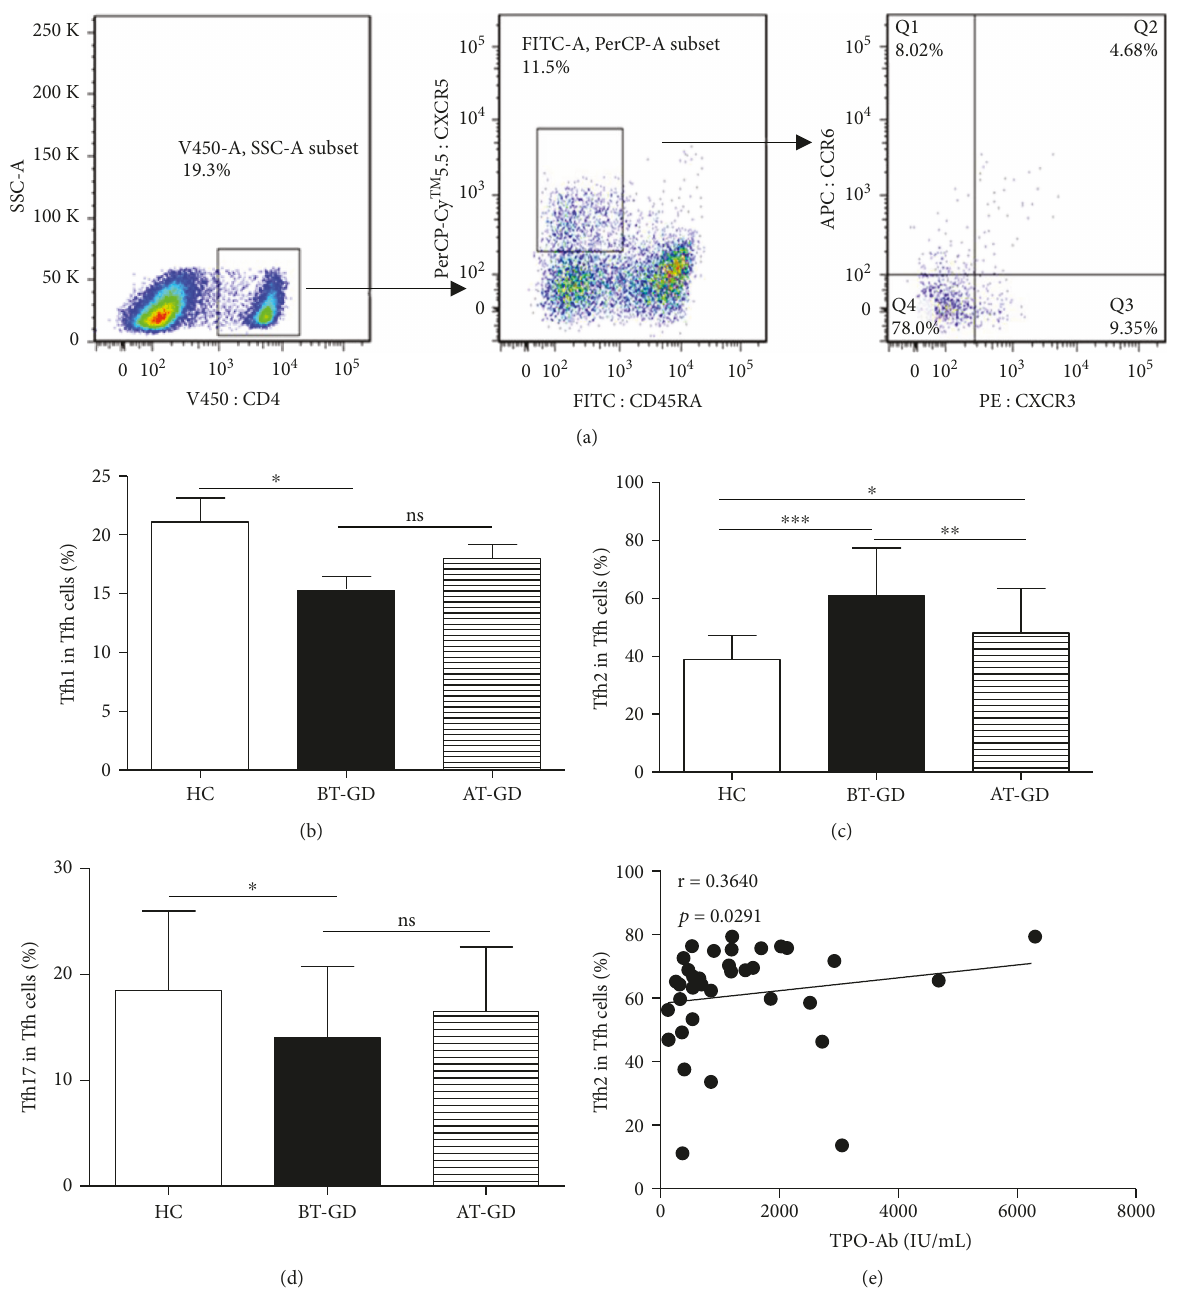
Figure 2: Frequency of circulating Tfh cell subsets in GD patients. (a) Representative dot plots demonstrate CXCR3 and CCR6 expression in cells gated for CD4, CD45RA, and CXCR5; (b) lower proportions of Tfh1 cells in GD patients; (c) overabundance of Tfh2 cells in GD patients; (d) decreased Tfh17 cells in GD patients; (e) relation of Tfh2 subset proportions with levels of serum TPO-Ab in GD patients. ∗ p < 0 05 , ∗∗ p < 0 01 , and ∗∗∗ p < 0 001 ; ns: no signi fi cant di ff erence. Tfh1 cells, CXCR3 + CCR6 − Tfh cells; Tfh17 cells, CXCR3 − CCR6 + Tfh cells; Tfh2 cells, CXCR3 − CCR6 − Tfh cells. GD patients (BT: 36, AT: 21) and 20 HC were enrolled in this